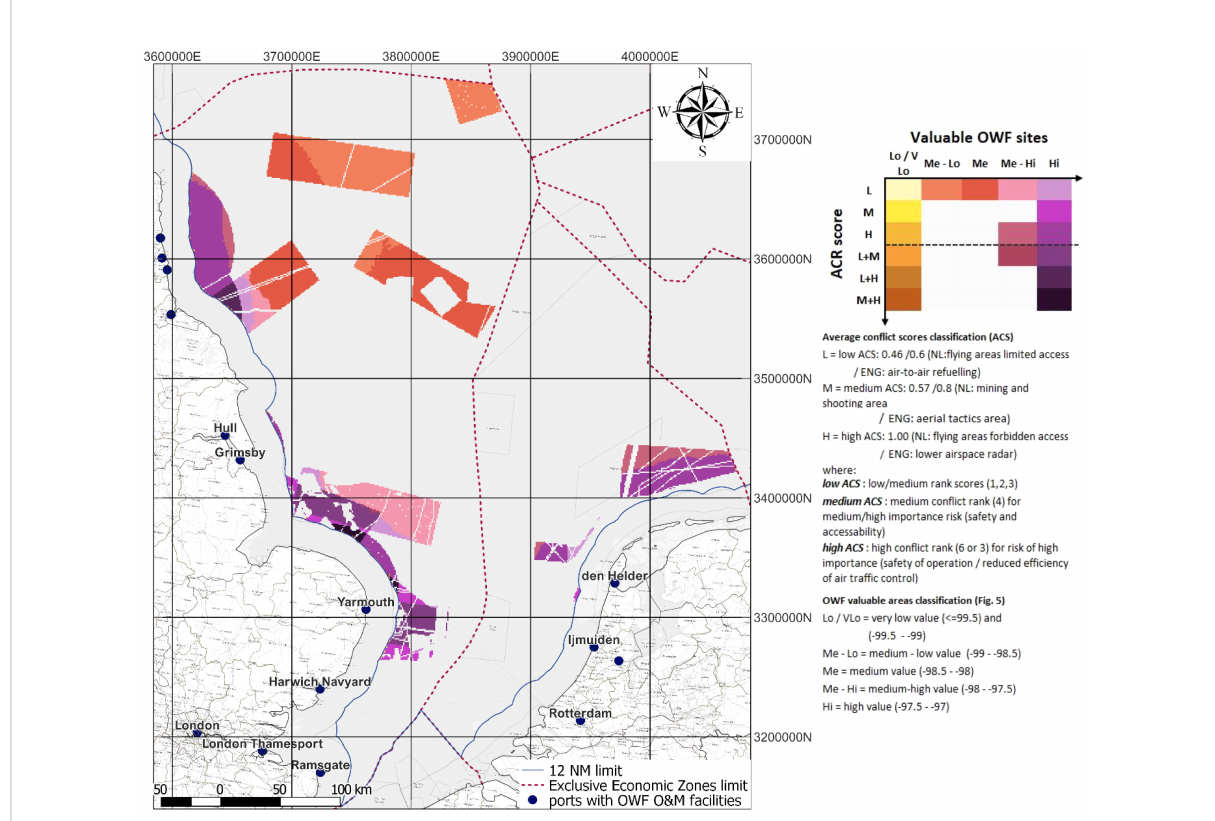
FIGURE 9 Spatial distribution (cumulated area of con fl ict) of con fl icts (ACS) within the OWF valuable sites, for nature protection areas sea user group